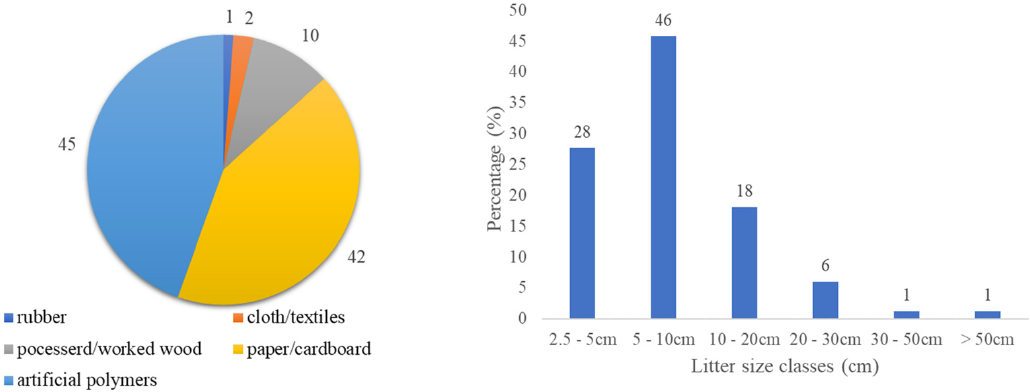
Figure 4. Percentage of materials of litter > 2.5 cm ( left ) and litter size classes ( right ) recorded at the Don River.